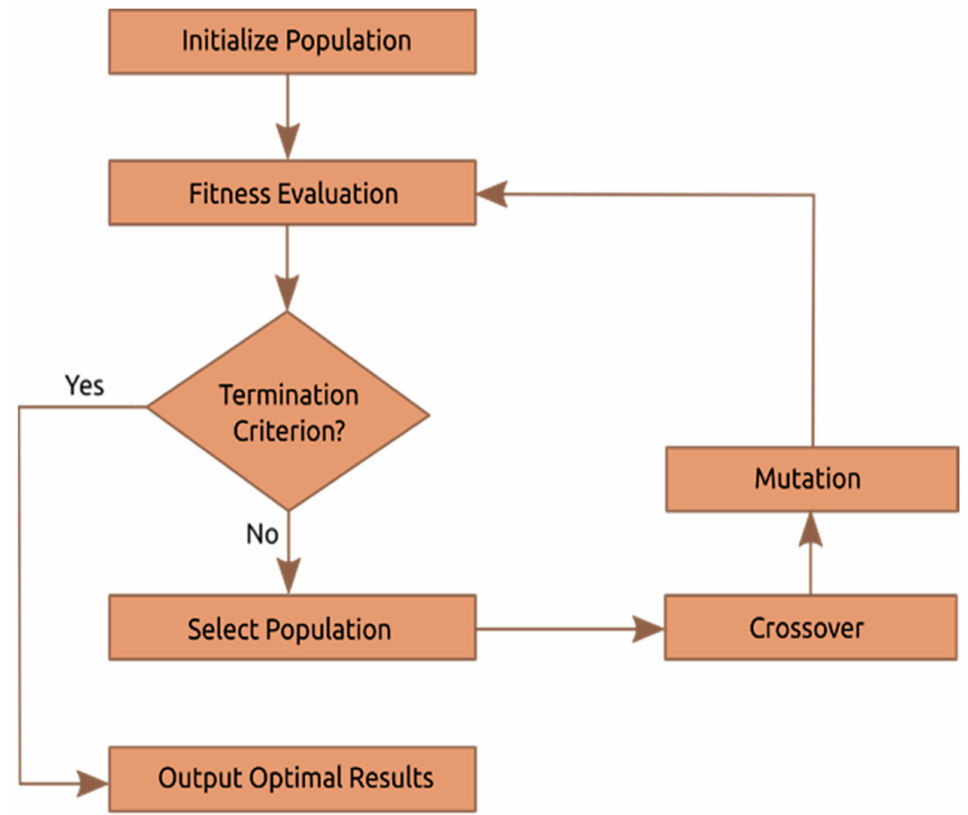
Figure 3. The implementation process of the genetic